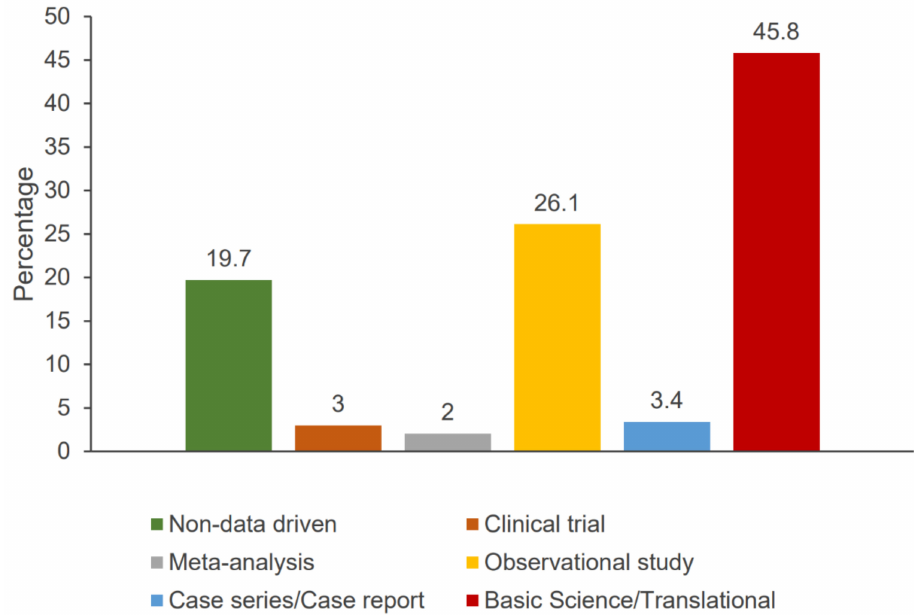
Figure 2. Cancer research output in the UAE by the type of the publication over the 20-year period from 2001 to